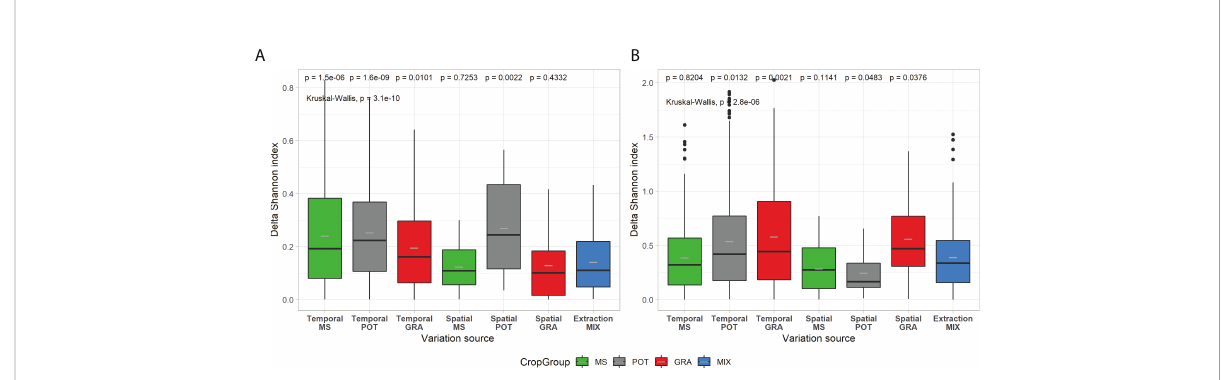
FIGURE 5 Box-and-whisker plots of Shannon diversity for spatial, temporal and technical variability of prokaryotic (A) and fungal (B) communities. Crop management codes: (MS, Maize/Soybean; POT, Potato; GRA, Grassland; MIX (Maize/Soybean and Potato). Boxplots are in the same format as those described in Figure 1. Kruskal-Wallis tests and post hoc pairwise Wilcoxon-test comparisons follow a similar format to Figure